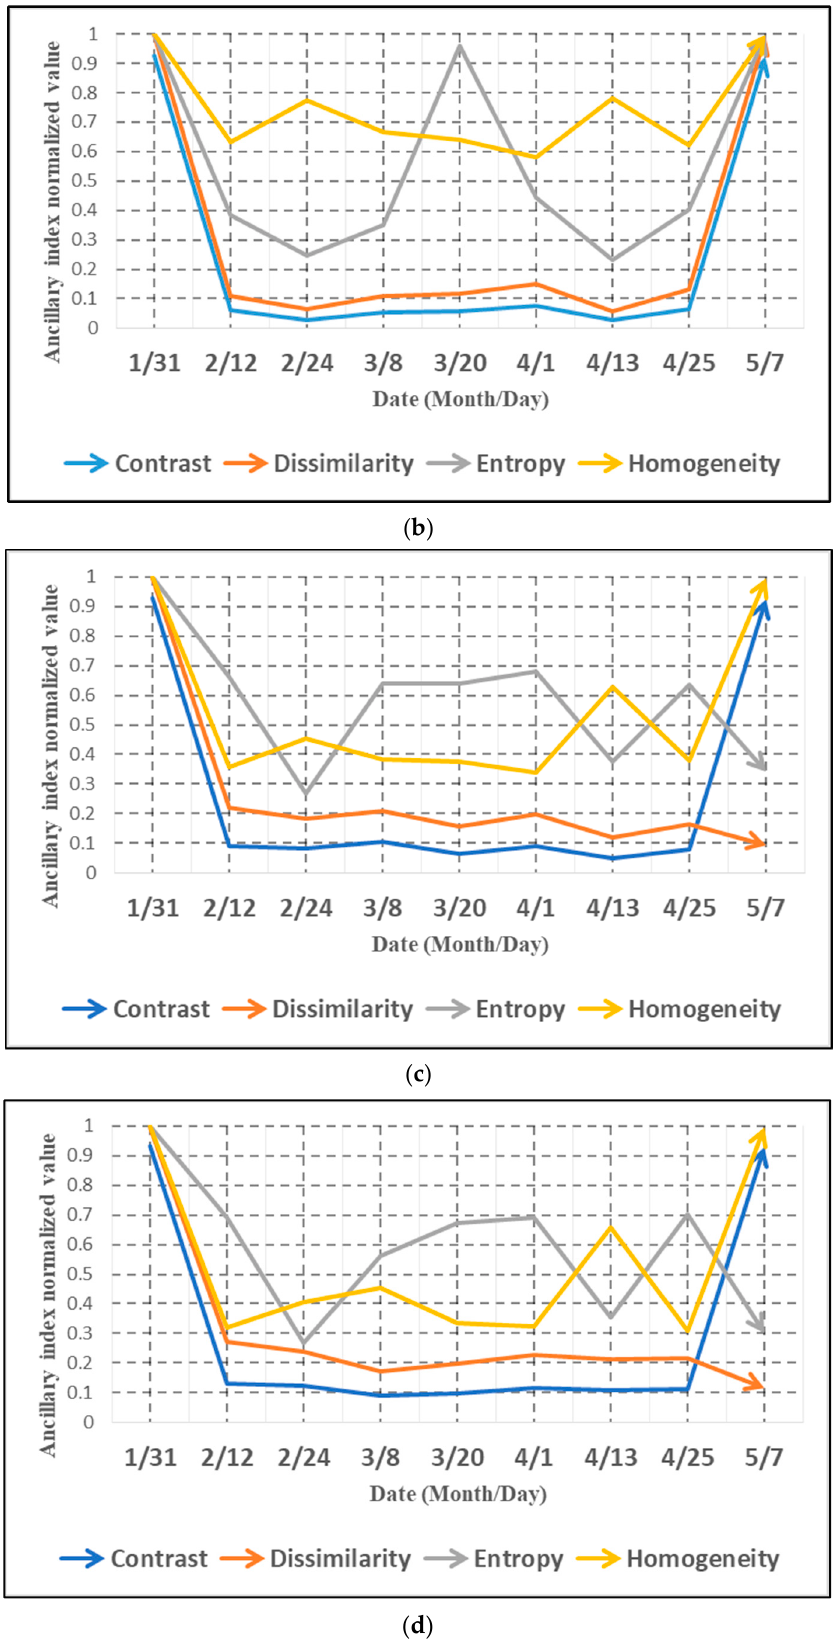
Figure 6. Sentinel-1A VH and VV variation, ( a ) paddy rice (VH), ( b ) non-paddy rice (VH), ( c ) paddy rice (VV), and ( d ) non-paddy rice